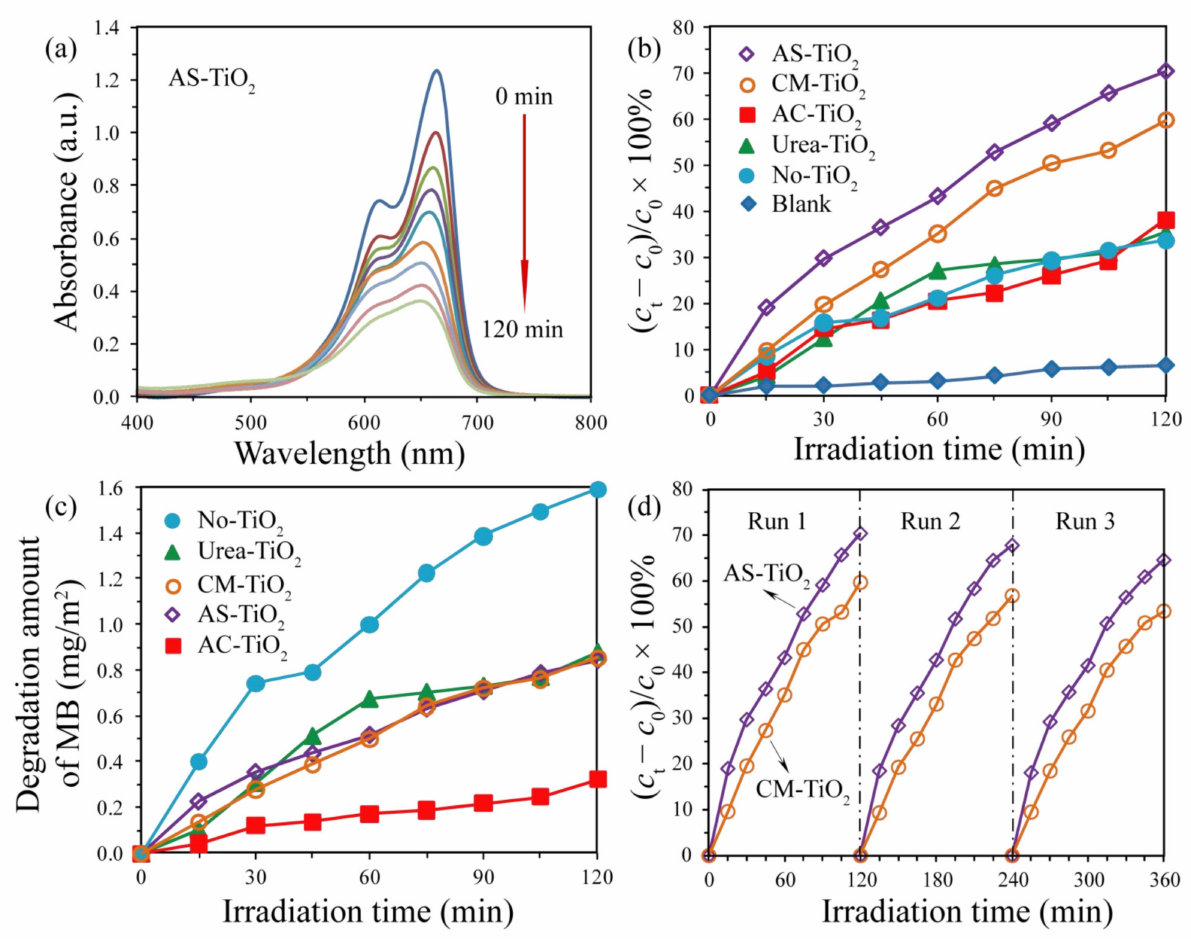
Figure 7. ( a ) Temporal adsorption spectral changes of MB in aqueous AS-TiO 2 suspensions under UV illumination; ( b ) photocatalysis degradation efficiency of MB with or without TiO 2 sample under UV illumination; ( c ) photocatalysis degradation amount of MB with different TiO 2 samples under UV illumination; ( d ) recycled performances in the presence of AS-TiO 2 and CM-TiO 2 samples for photodegradation of MB